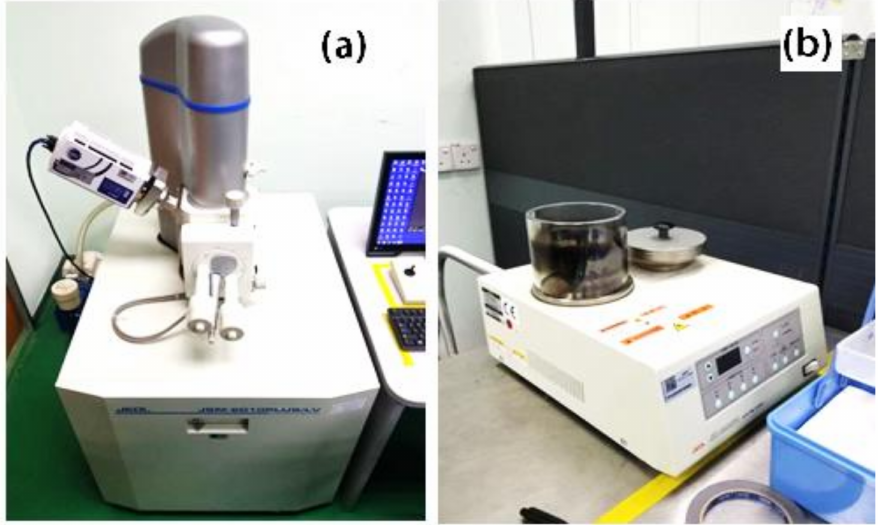
Figure 5. The laboratory setup for the morphology: ( a ) SEM and ( b ) the platinum coating